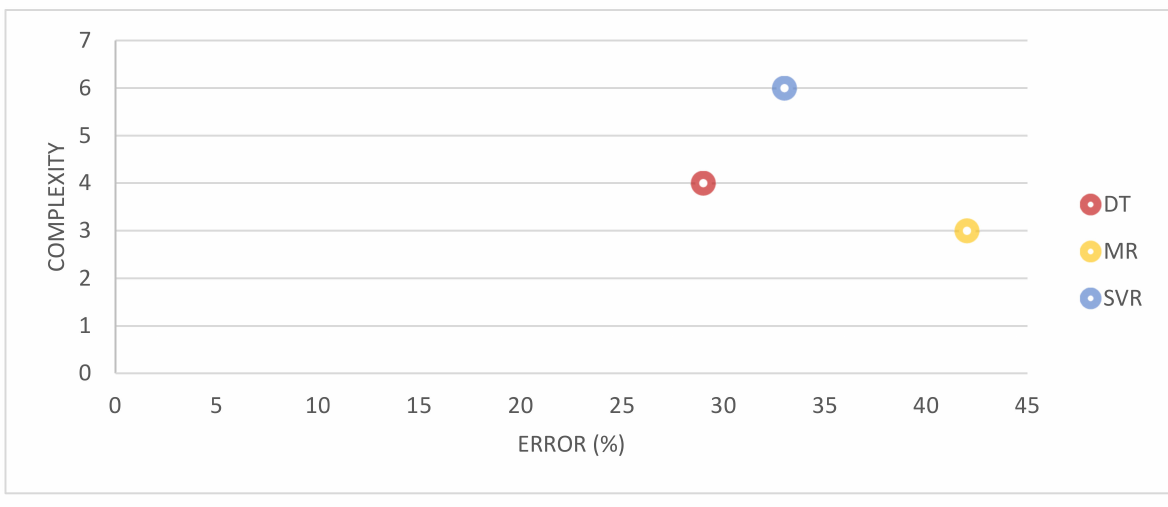
Figure 7. The optimal trade-offs between complexity and error of each estimation